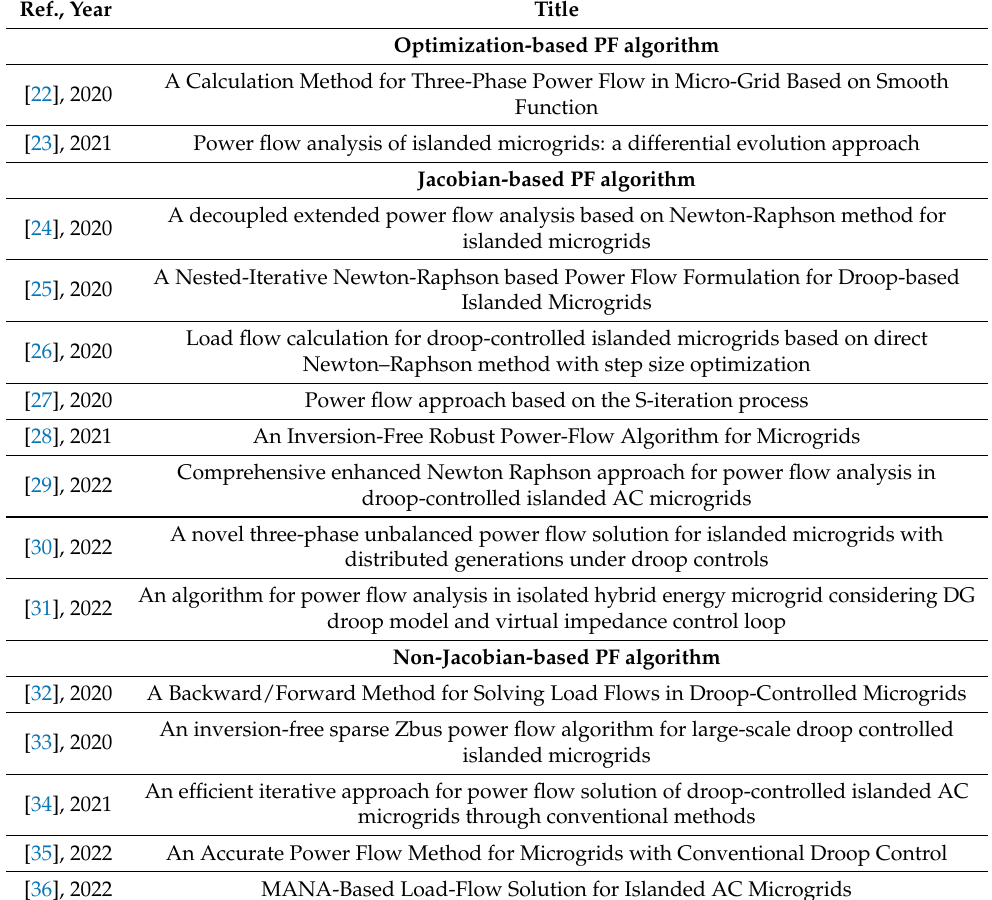
Table 1. A summary of major PF algorithms of islanded DRACMs proposed recently. Ref., Year Optimization-based PF